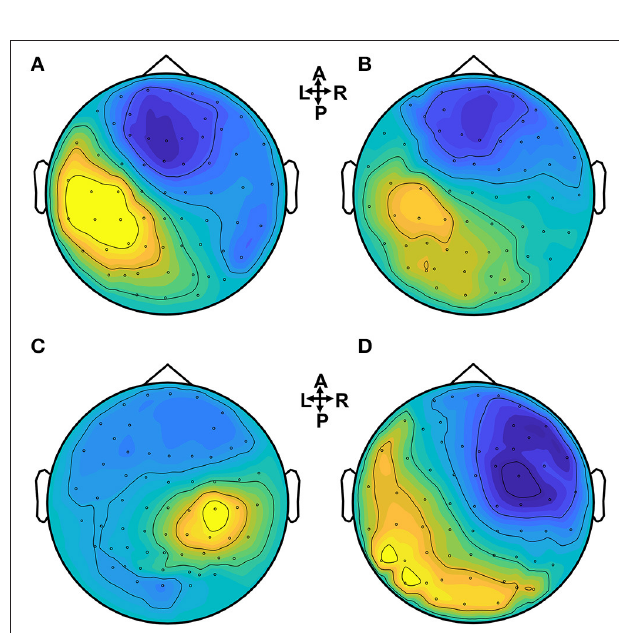
FIGURE 4 | Brain topographies of the P50 peak for control and stroke subjects when a dominant hand (for controls) or an affected hand (for stroke) is stimulated. (A,B) Controls, (C) stroke 1, (D) stroke 2.